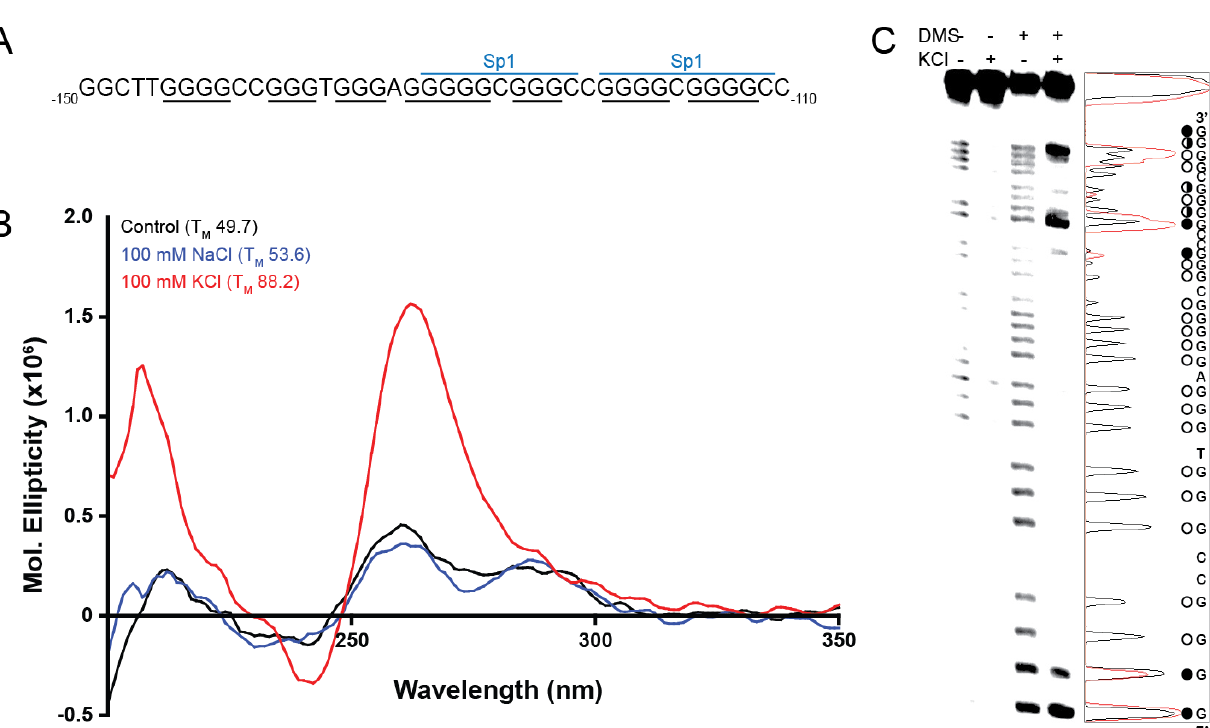
Figure 1. ( A ) The guanine-rich region of DNA spanning -110 to -150 bp upstream of the transcriptional start site contains seven runs of continuous G’s (underlined) and two Sp1 binding sites (spanning blue lines). This region ( B ) forms a weak, mixed species G4 in the absence of salt (black line) or 100 mM NaCl (blue line), and a stable, predominantly parallel, G4 in the presence of 100 mM KCl (red line). ( C ) DMS footprinting in the absence and presence of 140 mM KCl shows an induction of protection of a number of guanines, indicative of a mixture of G4 species. Histograms of the cleavage pattern in the absence (black line) and presence (red line) of KCl were used to determine the protection pattern indicated by the circles to the right of the figure: filled circle = hyper-cleaved, half-filled circle = partial protection indicative of protection within a subset of the equilibrating G4s, open circle = full protection indicative of incorporation in the majority of equilibrating G4